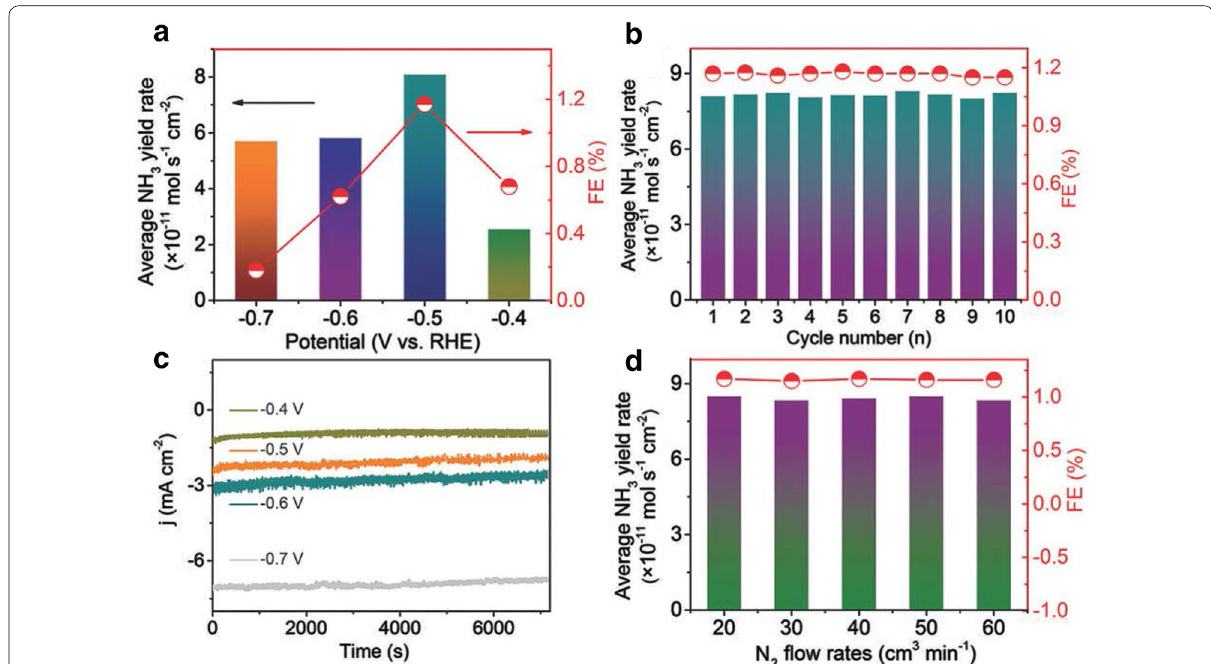
Fig. 5 a Average NH 3 yield and Faradaic efficiency of MoS 2 /CC at different potentials. b Recycling test performed at current density curves for MoS 2 /CC for varying NRR potentials. d Yield ad Faradaic efficiency at different N 2 flow rates at permission [33] Copyright 2018, Wiley – VCH